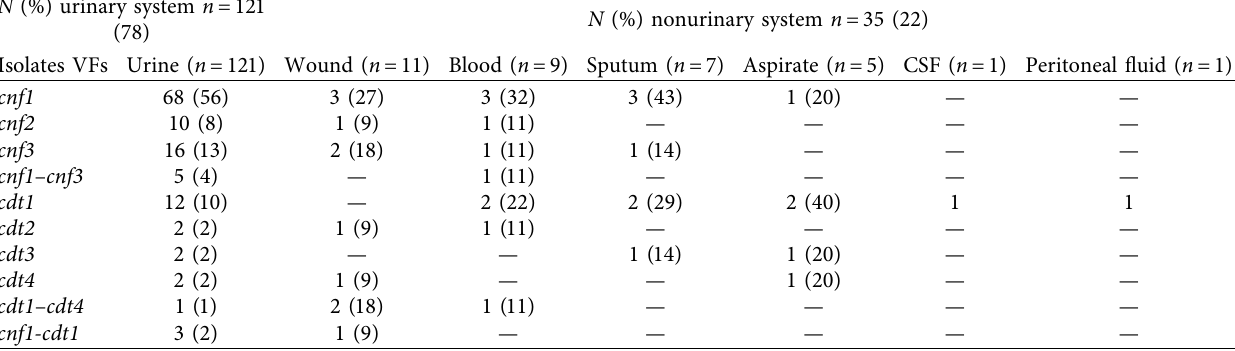
Table 6: Te distribution of 156 ExPEC isolates virulence genes by phylogenetic group and clinical origin.